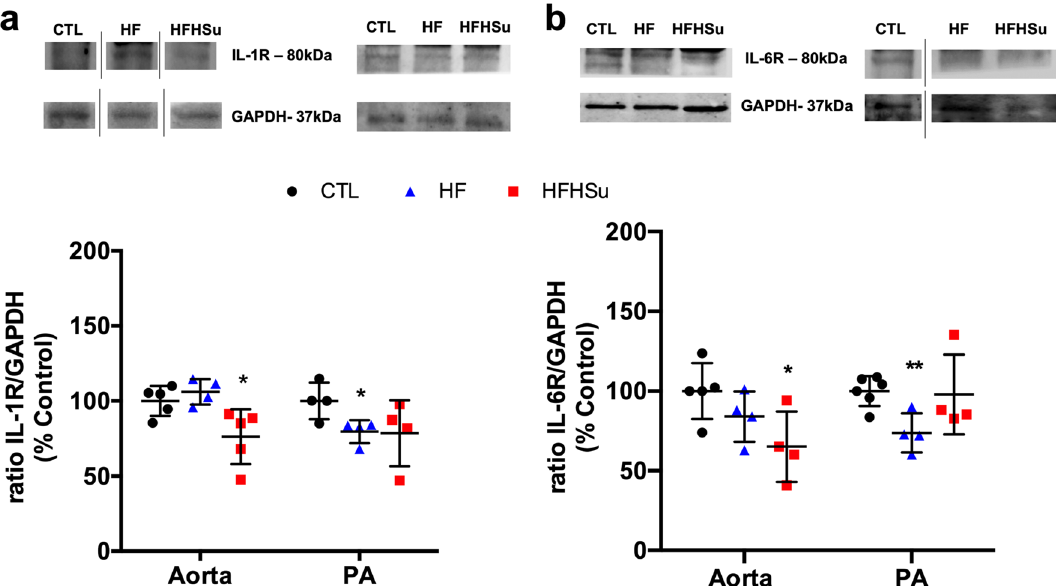
Figure 6. Effect of prediabetes and early phase type 2 diabetes on inflammatory markers involved in endothelial dysfunction. Average expression of ( a ) IL-1 receptor (IL-1R, 80 kDa) and ( b ) IL-6 receptor (IL-6R, 80 kDa) and the loading protein GAPDH (37 kDa) in aorta and pulmonary artery (PA) of control (n = 4–5), HF (n = 3–5) and HFHSu (n = 3–4) animals. Representative western blots for each protein studied are depicted above the respective graphs. Representative bands were cropped due to the sample order in the membrane. For complete membrane image see Supplementary data. Values are presented as scatter plots ± SD; One-way ANOVA with Dunnet’s comparison test. * p < 0.05 and ** p < 0.01 versus control animals.